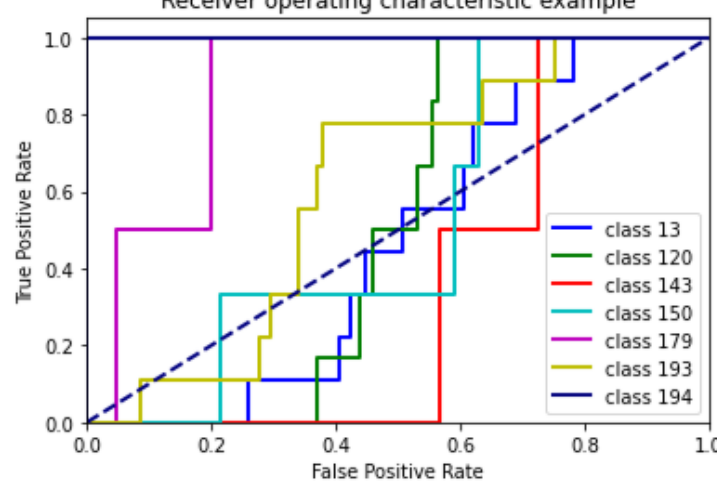
Figure 8. ROC-AUC curve for the cross-sessions experiment.